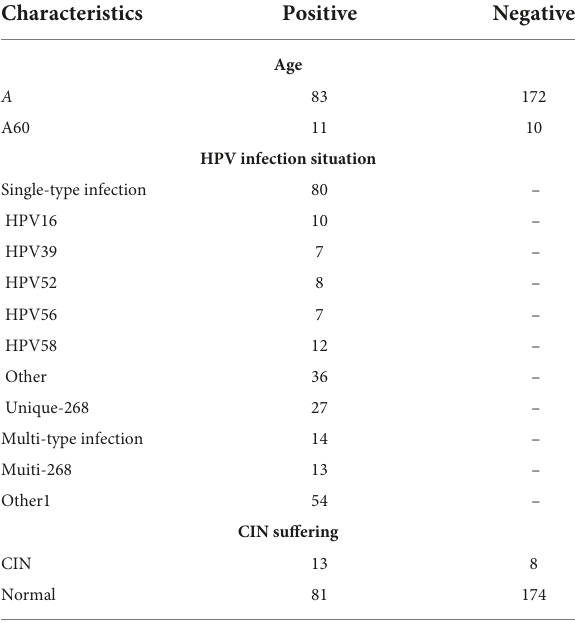
TABLE 1 Patients age and infection